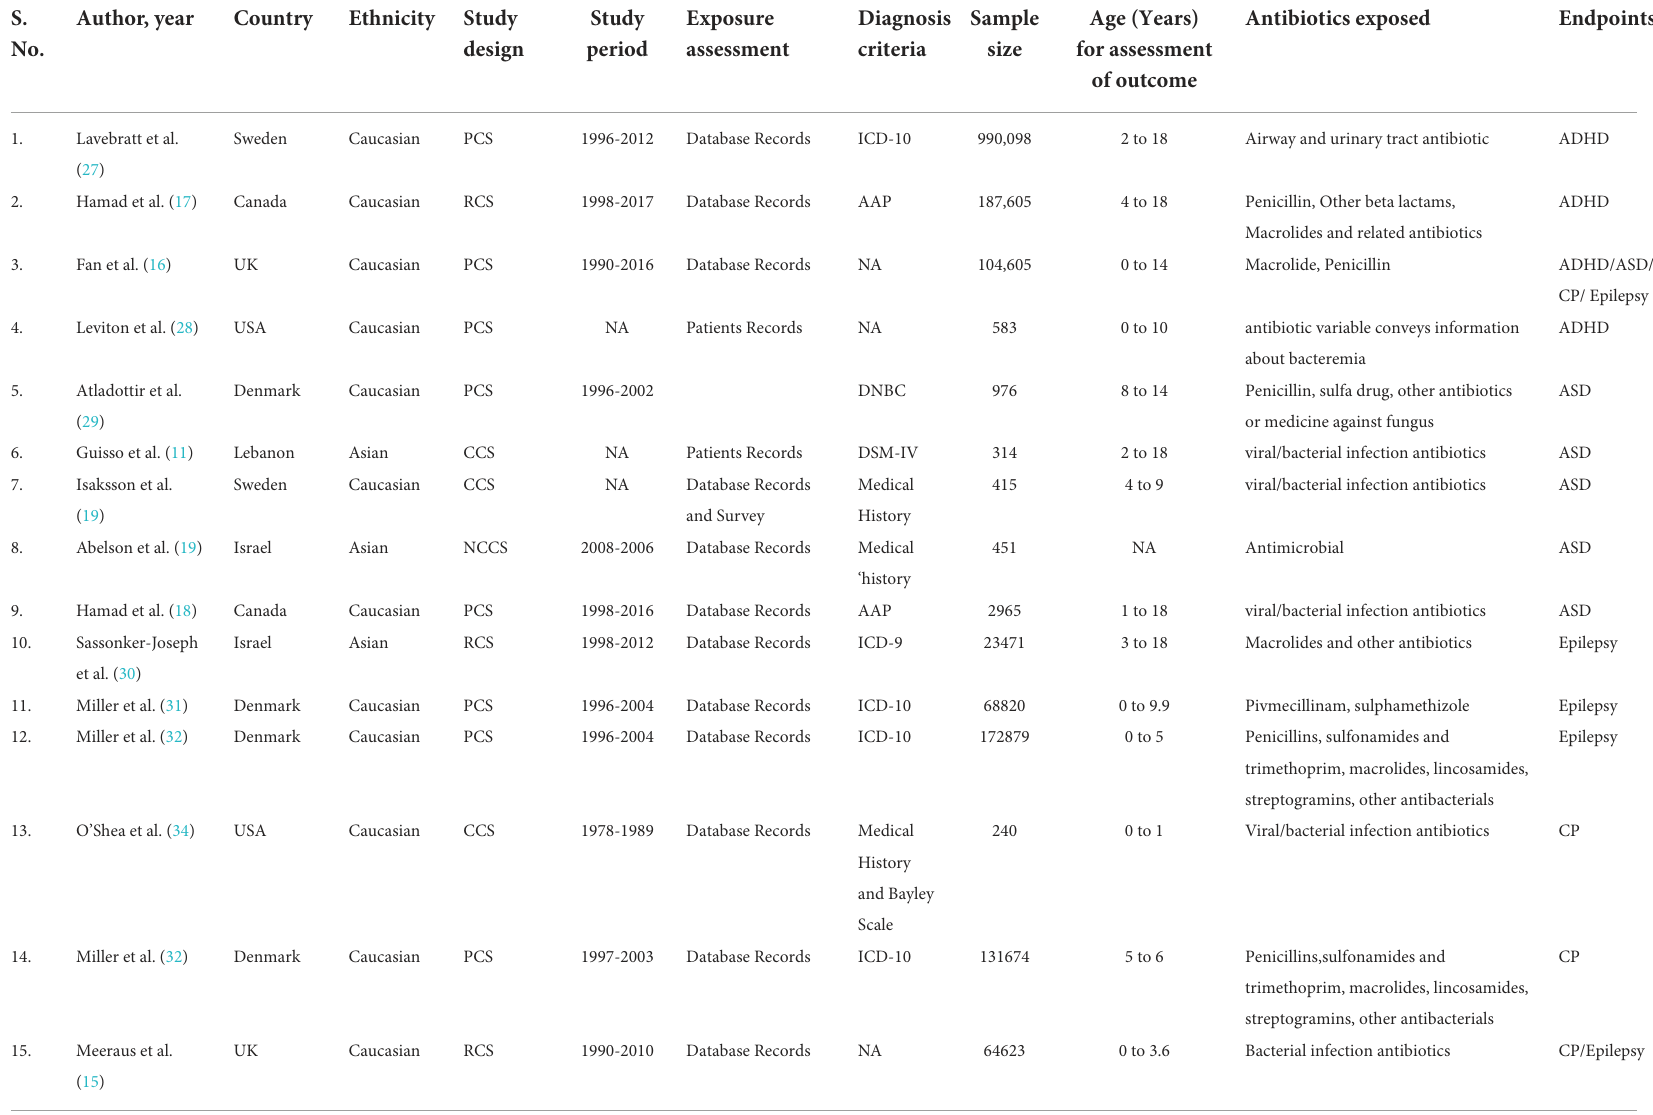
TABLE 1 Baseline characteristics of included studies in the meta-analysis investigating the association between prenatal antibiotic exposure and the risk of neurodevelopmental disorders in the offspring.